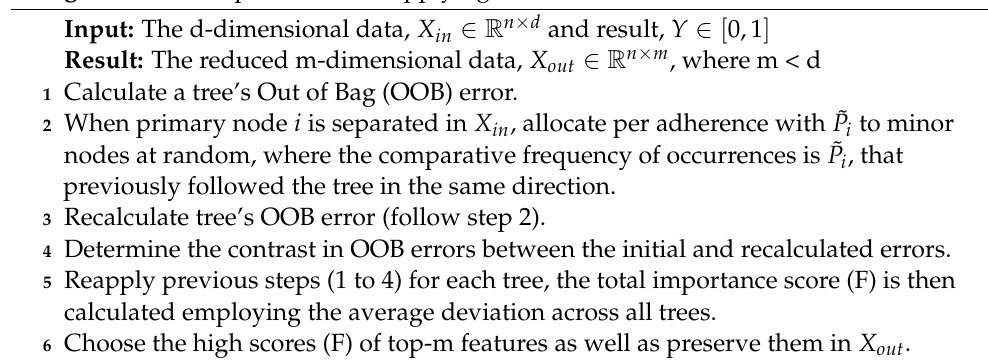
Algorithm 2: The procedure for applying RF-based FS